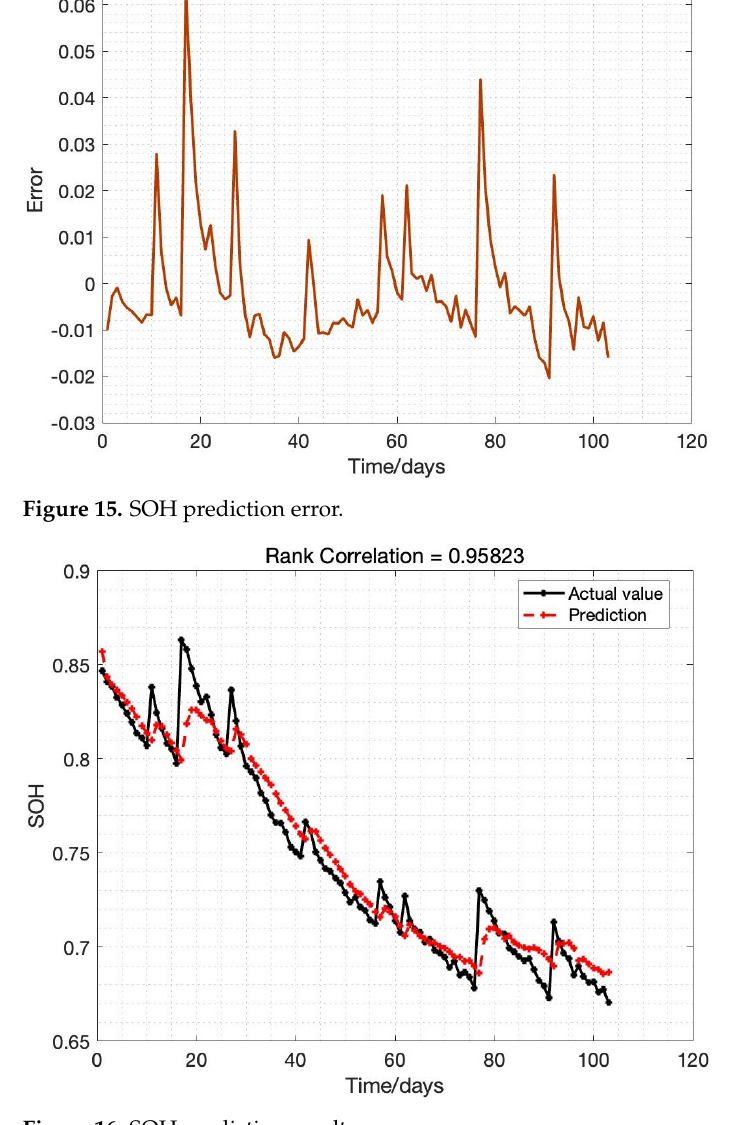
Figure 16. SOH prediction